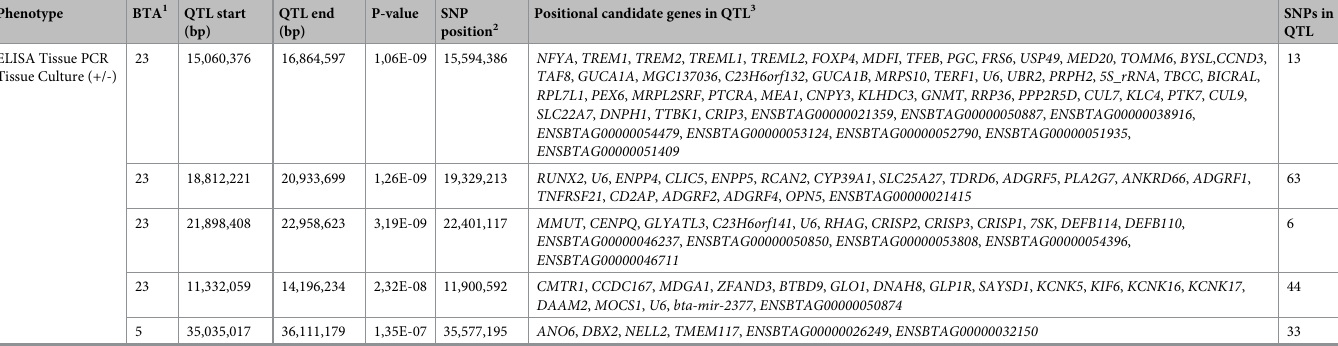
Table 3. Quantitative trait loci (QTLs) surpassing the significance threshold (P < 5 × 10 − 7 ) for evidence of an association with MAP infection status.